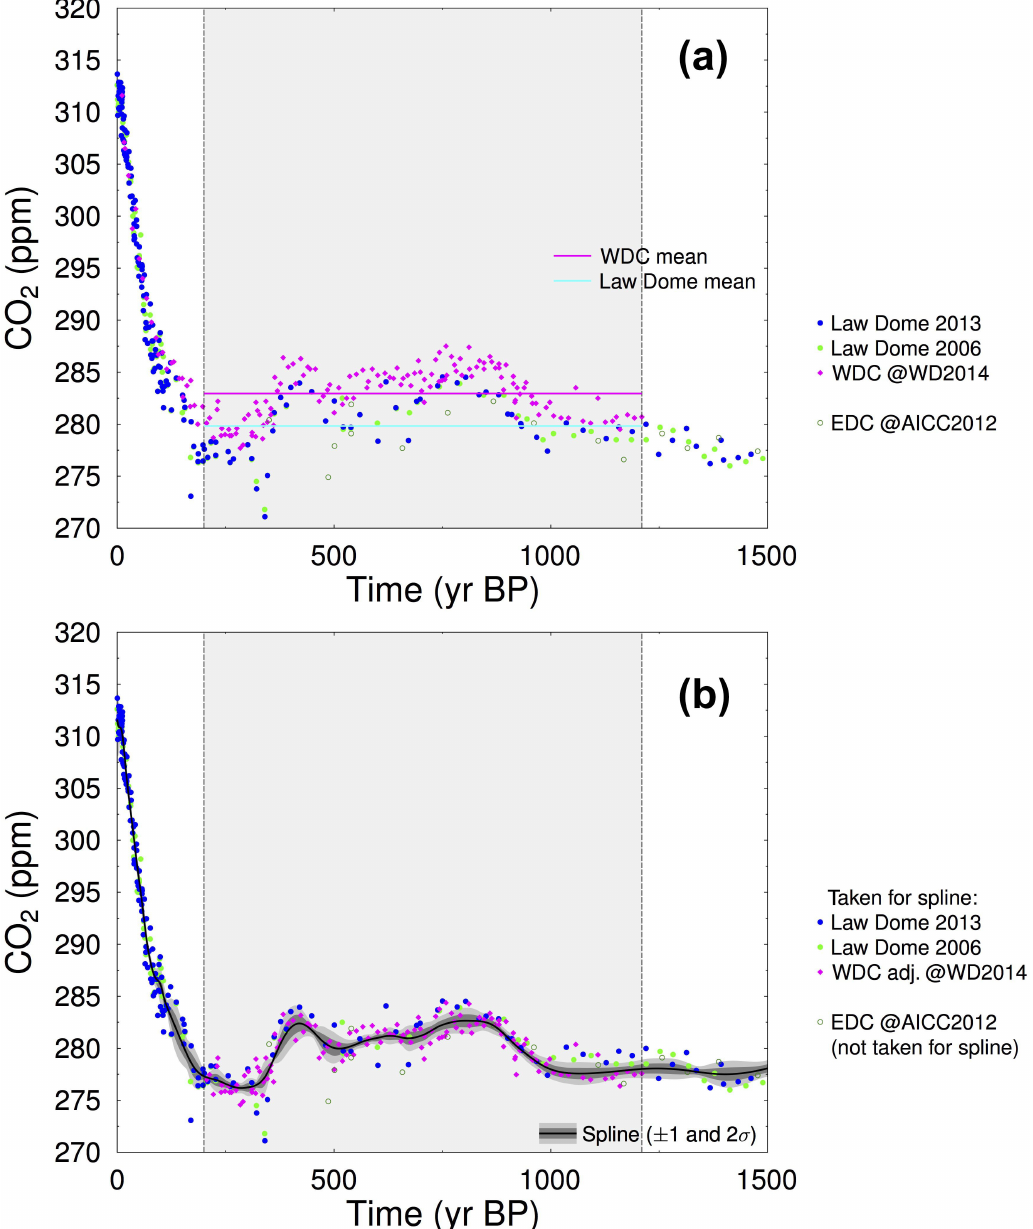
Figure A1. Details of differences between CO 2 of Law Dome (MacFarling-Meure et al., 2006; Rubino et al., 2013), EDC (Monnin et al., 2004), and WDC (Ahn et al., 2012; Bauska et al., 2015) during the last 1500 years, showing how the adjustment of the WDC has been calculated. The grey area marks the pre-anthropogenic time window (before 1750CE) covered in WDC (200–1210BP), from which the difference in CO 2 to WDC and Law Dome records has been determined. Horizontal lines mark the mean values for the different ice cores (cyan: Law Dome (all data); magenta: WDC). The mean offset between the WDC and Law Dome of 3.13ppm is subtracted from the WDC data in (b)